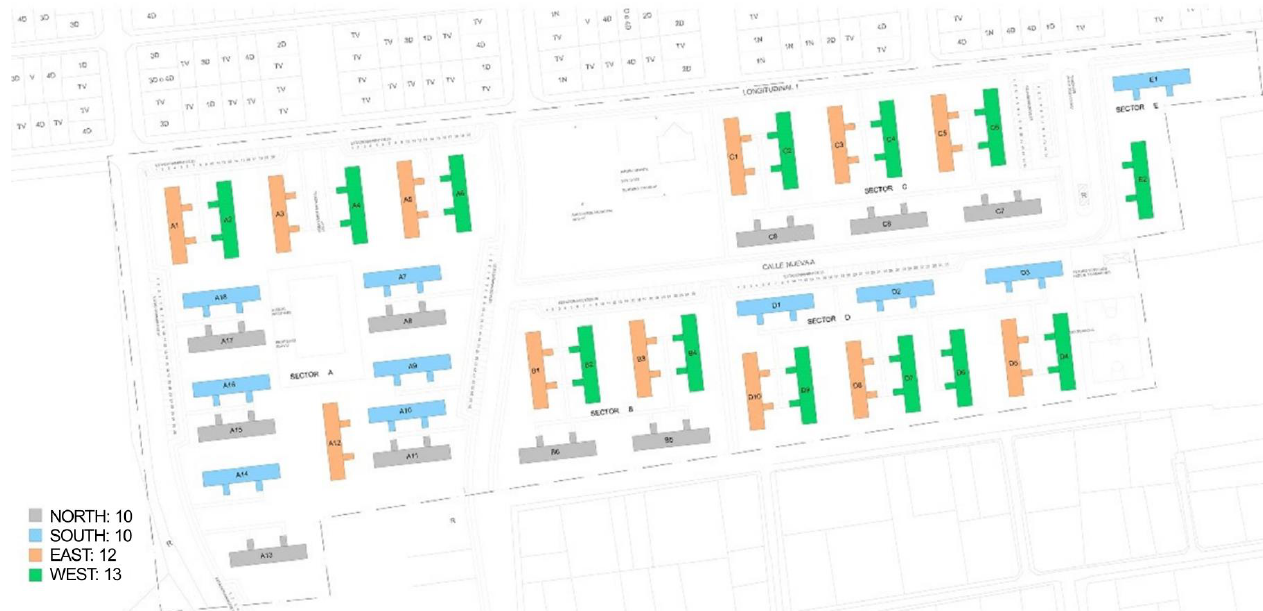
Figure A3. Blocks urban distribution (authors’ own preparation).